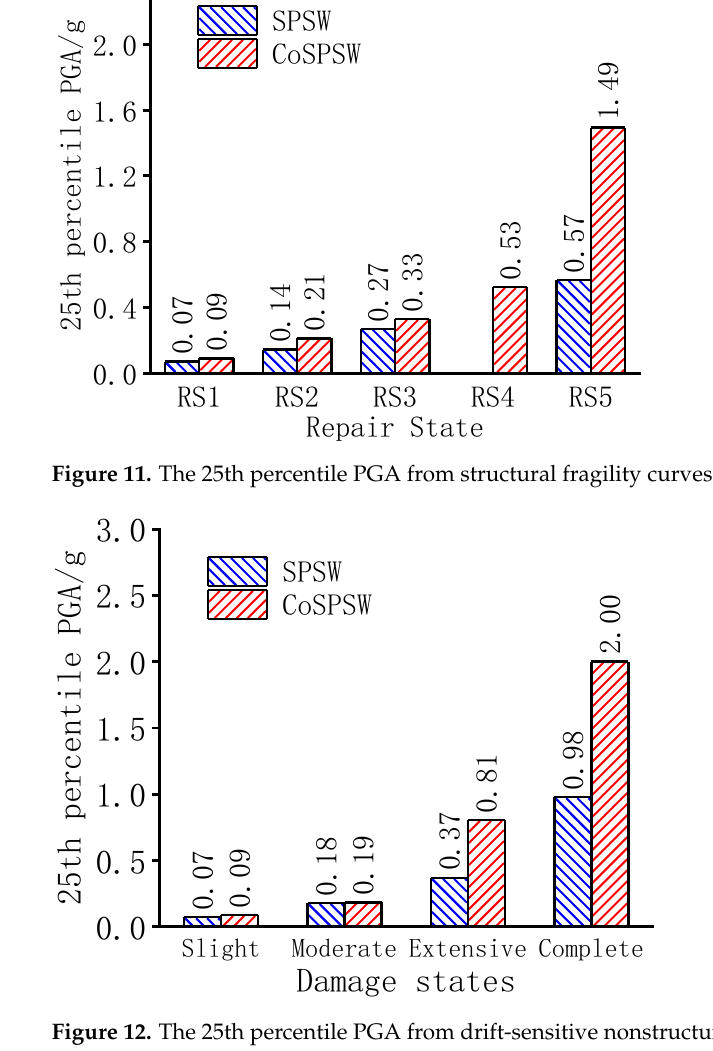
Figure 12. The 25th percentile PGA from drift-sensitive nonstructural fragility curves.